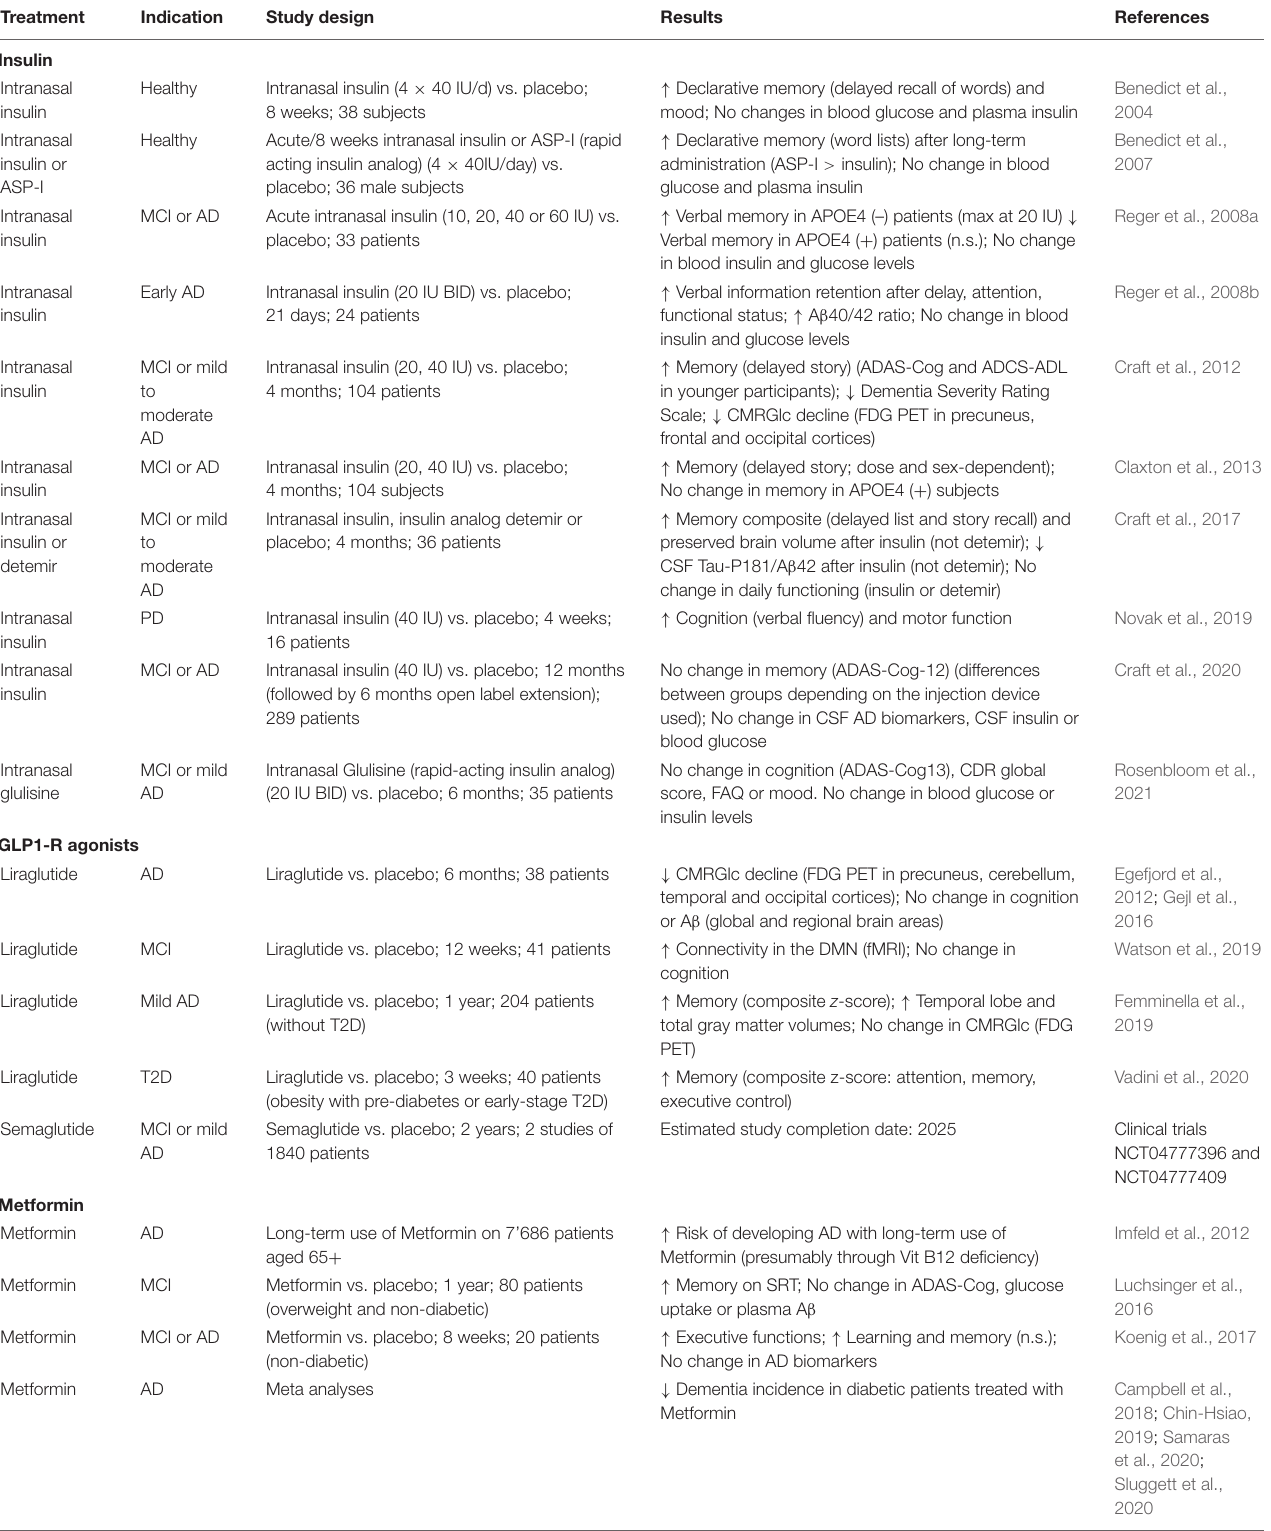
TABLE 2 | Clinical evidence of compounds targeting brain energy metabolism in neurodegenerative diseases.